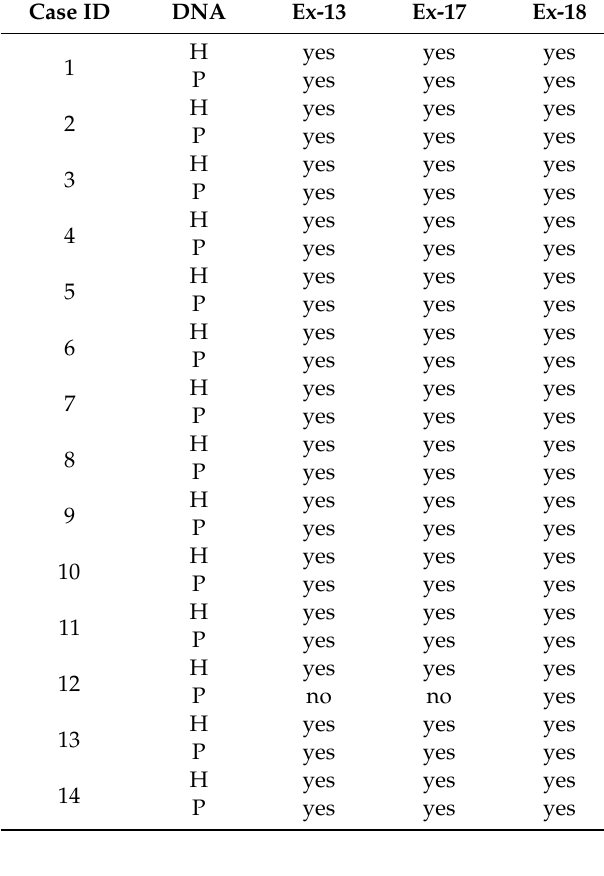
Table 3. Result of the PCR amplification obtained for each DNA fraction (healthy and pathologic) of the samples analyzed, and for each primer pair. H: healthy; P: pathologic. Ex: exon.